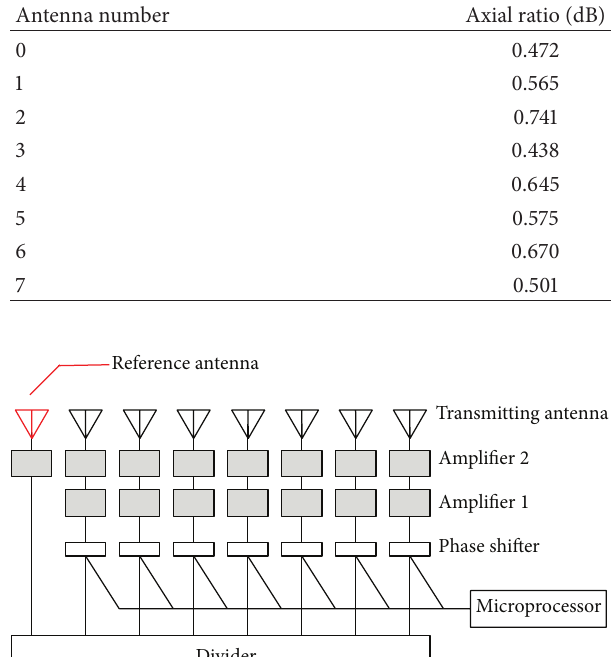
theory. The directions of SRAs are rotated sequentially, which would also engender a high axial ratio. Details of SRAs have been reported [6].